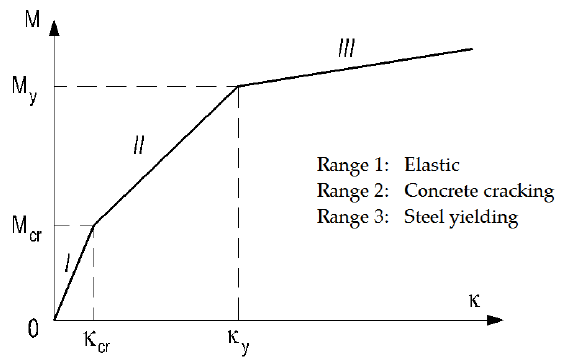
Figure 12. Idealization of M –κ relationship for reinforced concrete element according to [38].